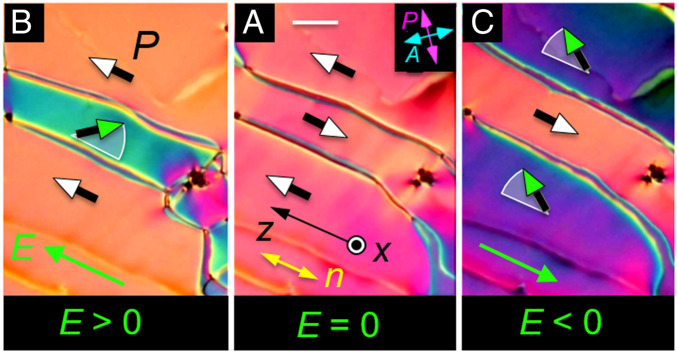
DTLM images showing polar Freedericksz twist transition in ferroelectric domains with opposite polar orientation at T = 120 °C. These domains, grown field-free upon cooling from the N phase to this temperature, have a polarization density P. (A) Field-free initial state showing three domains separated by domain walls, each domain having n(r) along the buffing direction z. (B) Application of an ultra-small, positive test field Ez = 1 V/cm induces a birefringence color change resulting from in-plane reorientation of n(r) in the center domain, leaving the upper and lower domains unchanged. (C) Application of Ez < 0 induces an in-plane reorientation of n(r) in the upper and lower domains. There is little optical change or reorientation in the central domain. If the field is returned to E = 0, the system returns to the starting state (A). These observations demonstrate that the domains are polar and also enable the absolute determination of the direction of P(r): domains that have the orientation preferred by the applied field do not reorient. In this experiment, P(r) and n(r) within the domains rotate about x but the field is not large enough to move the domain walls, which are pinned by the surfaces. The polarization vectors (shaded green) and circular arcs (white) depict the field-induced reorientation of P(r) in the midplane of the cell: P(r) does not reorient at the surfaces in this experiment, remaining parallel to the buffing direction. These field-induced reorientations with P(r) starting nearly antiparallel to E are polar azimuthal Freedericksz transitions. The threshold field, EP = (π/t)2(KT/P), estimated using the measured P ∼5 µC/cm2 at T =120 °C (Fig. 3), is EP ∼1 V/cm, comparable to the fields employed here. t = 11 µm. (Scale bar, 30 µm.)